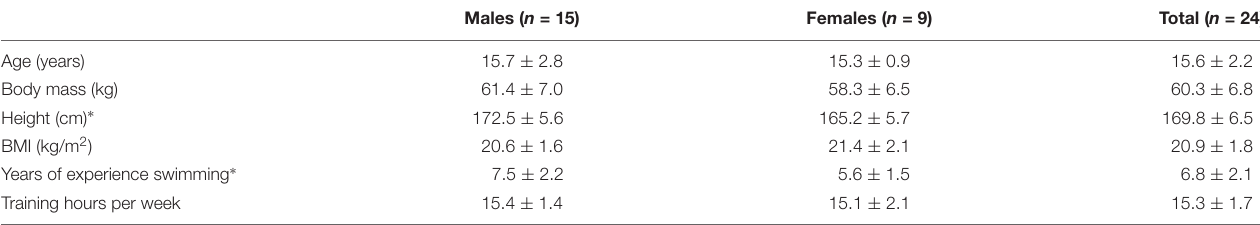
TABLE 1 | Demographic results on swimmers participating in the study a .